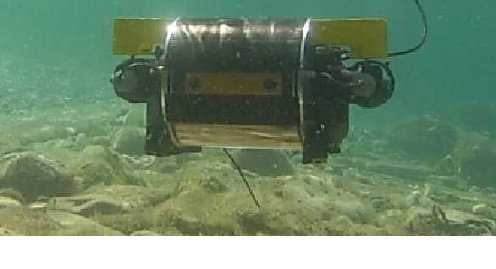
Figure 9. The Fugu-C.